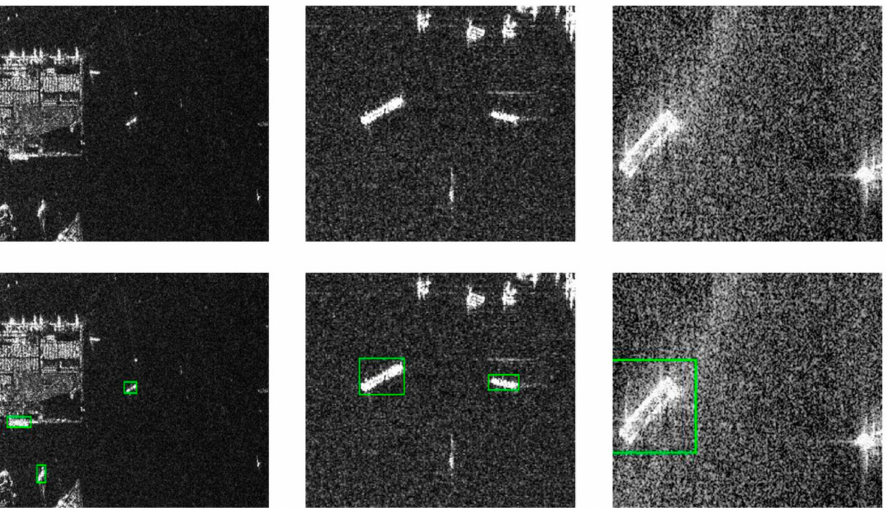
Figure 11. TWC-Net test results, ground truth for behavior 1, detection result for behavior 2, images in columns 1 and 2 are from SSDD, and images in column 3 are from